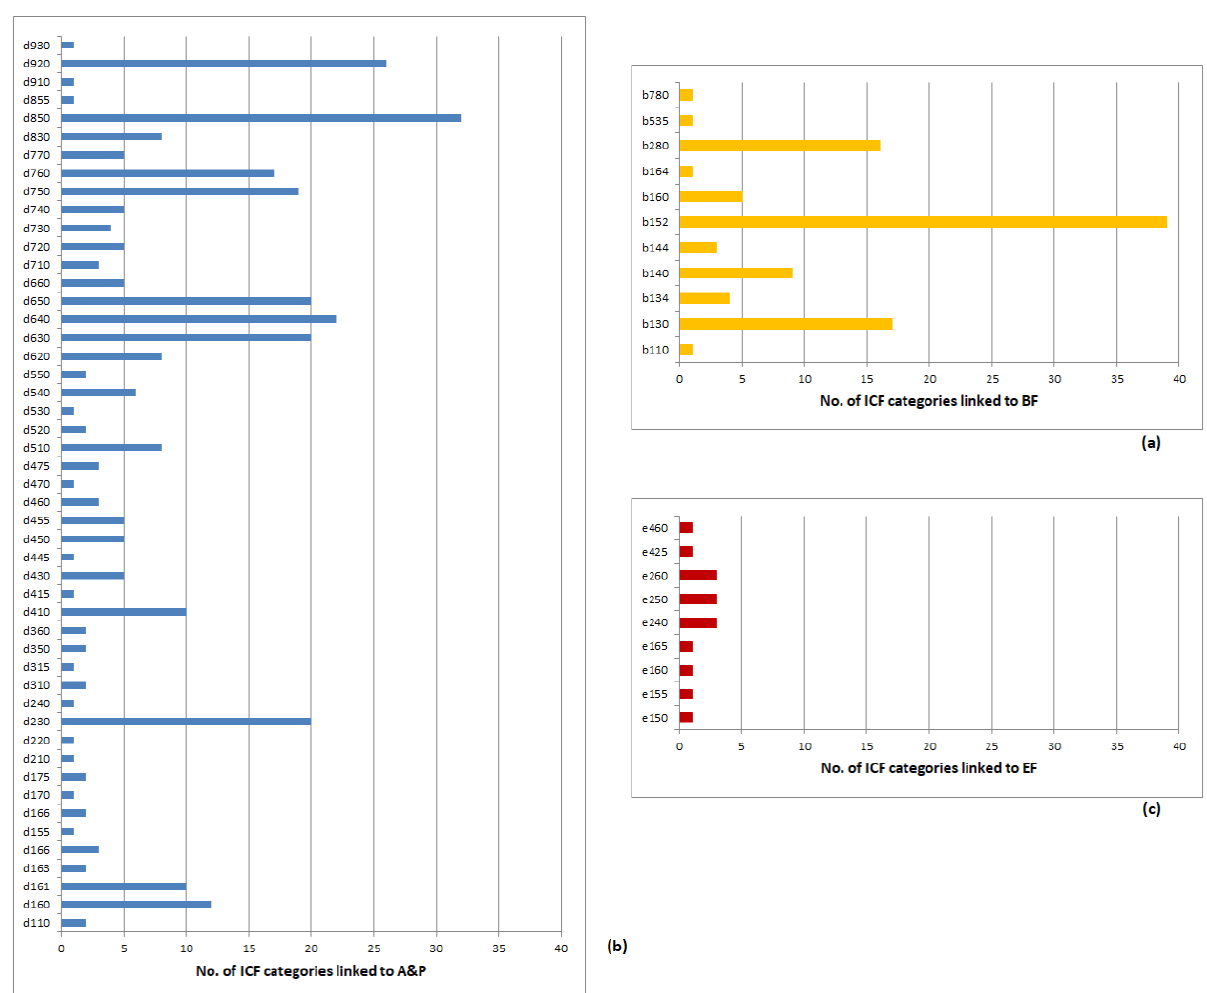
Figure 2. Overview of linked ICF categories for the three primary headaches. ( a ) Body Functions, ( b ) Activities and Participation, ( c ) Environmental Factors.